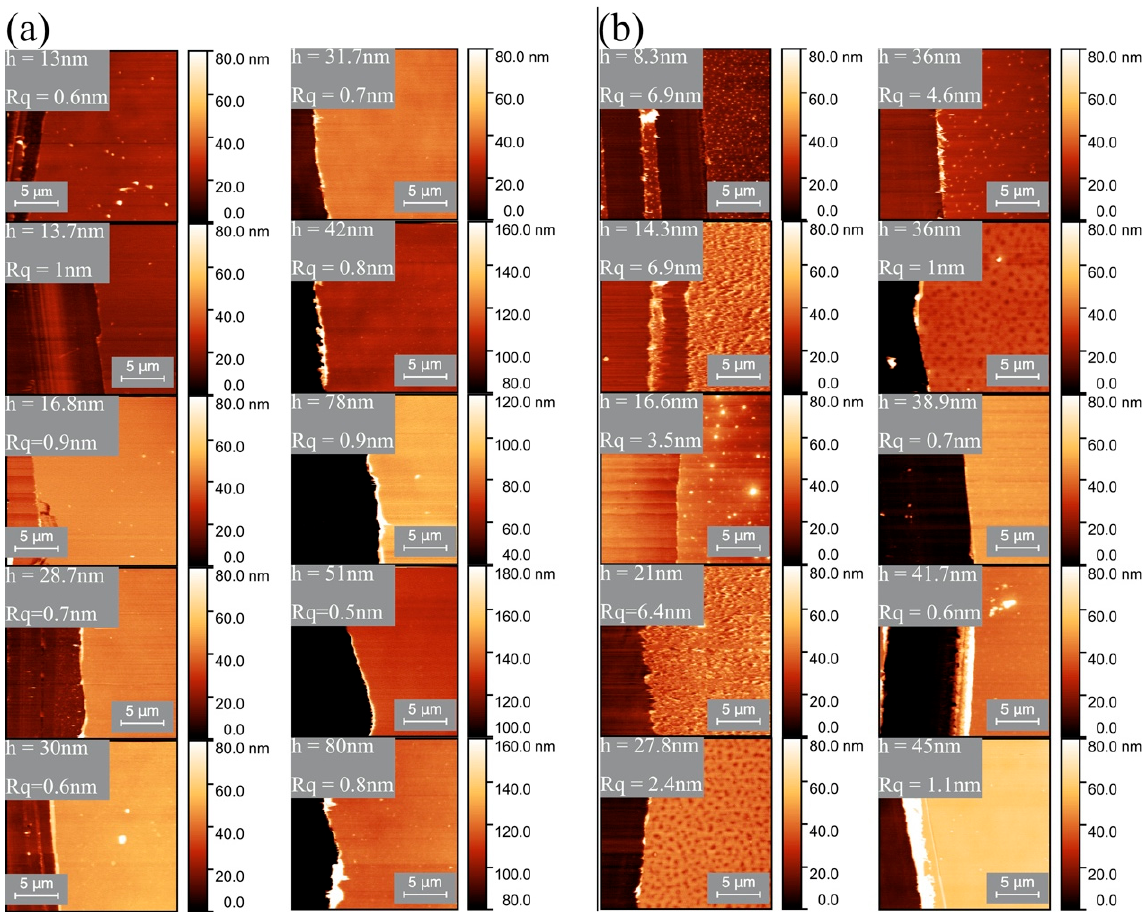
Figure 11. ( a ) AFM images showing the morphology of the solid films obtained from the high-molecular-weight polymer (B72). The films with different thicknesses have smooth surfaces. ( b ) AFM images showing the morphology of solid films obtained from the low-molecular-weight polymer (B98). Thin films have bumpy surfaces or form nodules. In each panel, the bright right part is the film, and the dark left portion is the trench.